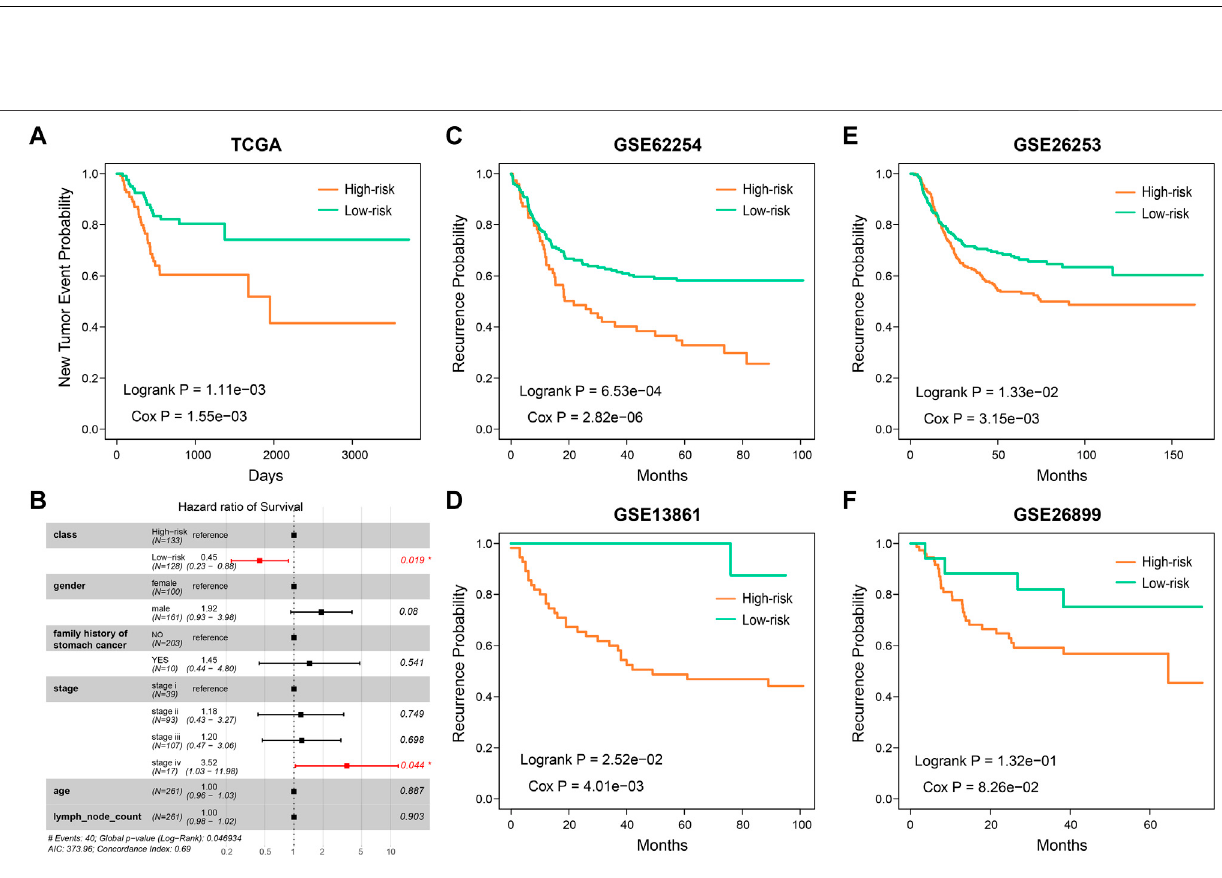
FIGURE 3 | The prognostic effect of the HR-LR model. (A) Multivariate Cox proportional-hazards regression result of SSA-NHEJ score and other clinical characteristics. (B) Validation of the prognostic effect of the SSA-NHEJ score in six GEO cohorts. n represents the number of samples in each GEO dataset.